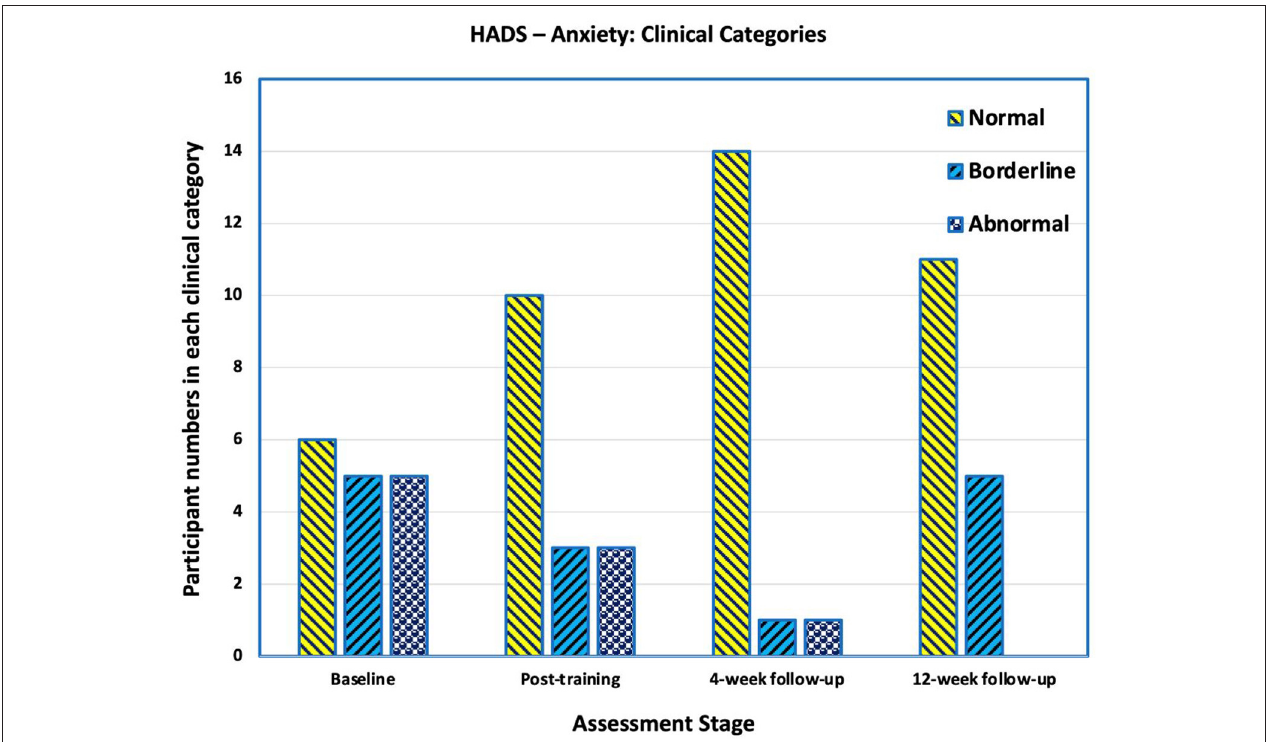
FIGURE 7 | Number of participants in each category in Hospital Anxiety and Depression Scale (HADS) for Anxiety. Scores of > 10 are “abnormal” and indicative of clinical anxiety, scores between 8 and 10 are categorised as borderline, and scores below 8 are categorised as normal. At baseline 6 participants had abnormal scores indicating clinical anxiety. At the 4-week follow-up, two had an abnormal score. By the final follow-up, four participants’ scores changed to borderline, three deteriorating and one